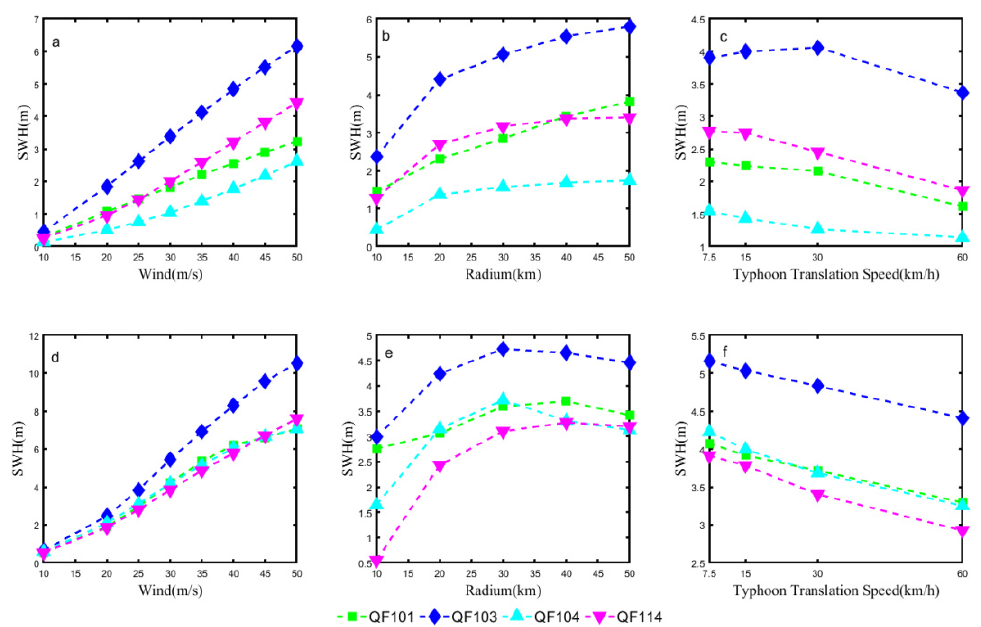
Figure 19. Variation in the maximum value of the significant wave height with ( a – d ) the maximum wind speed, ( b – e ) typhoon radius, and ( c – f ) typhoon translation speed for Typhoon Muifa/Lekima.